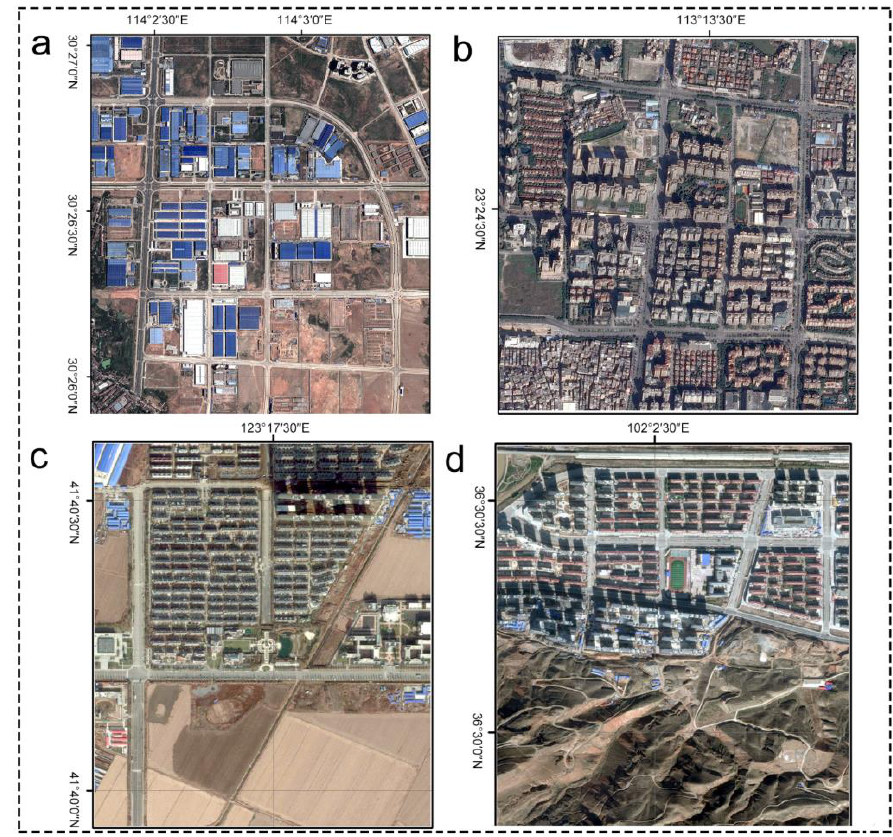
Figure 7. High-resolution images of representative subregions. ( a – d ) are the subregions selected from Wuhan, Guangzhou, Shenyang and Xining respectively.